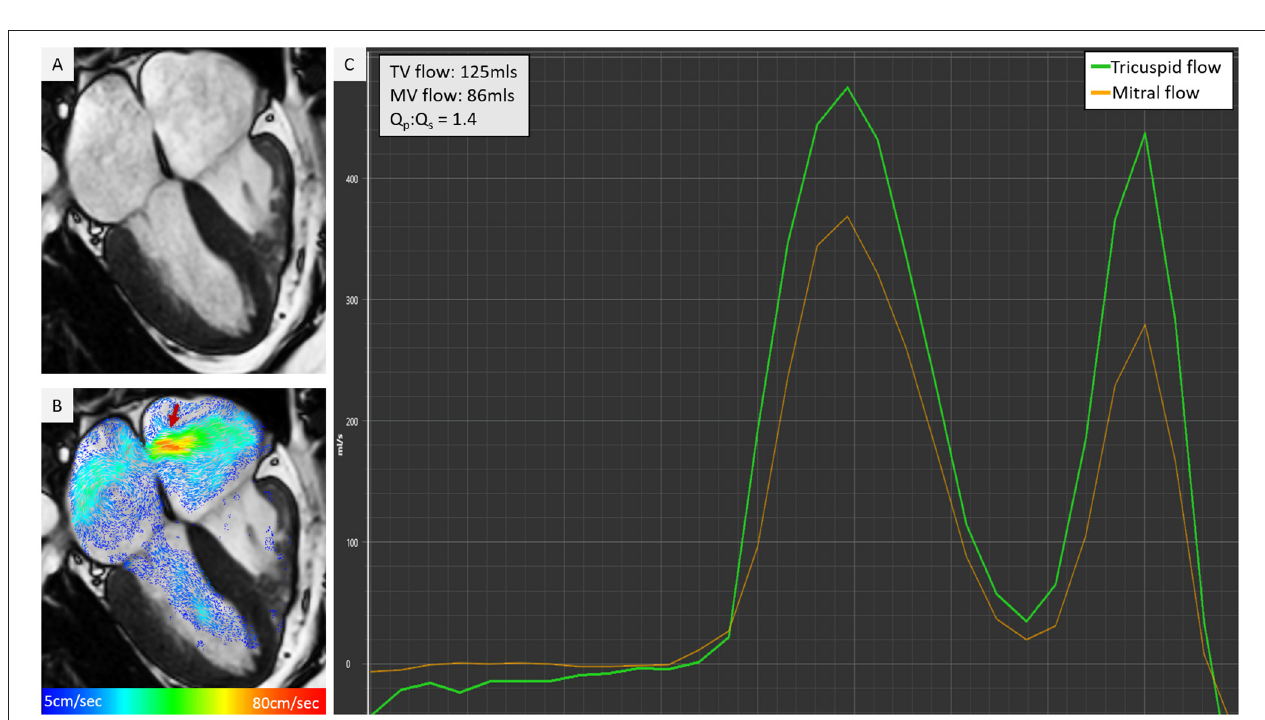
FIGURE 8 | Cine co-registered 4D flow visualisation can offer instant understanding of intra-cardiac shunts and other similar cardiac pathologies. In this figure, there is atrial septal defect that was not clearly recognised on cine (A) , however, with 2-directional vector visualisation in (B) , there was an obvious left to right shunt. This was quantified by retrospective valve tracking method and significant Qp, Qs was noted (C) .